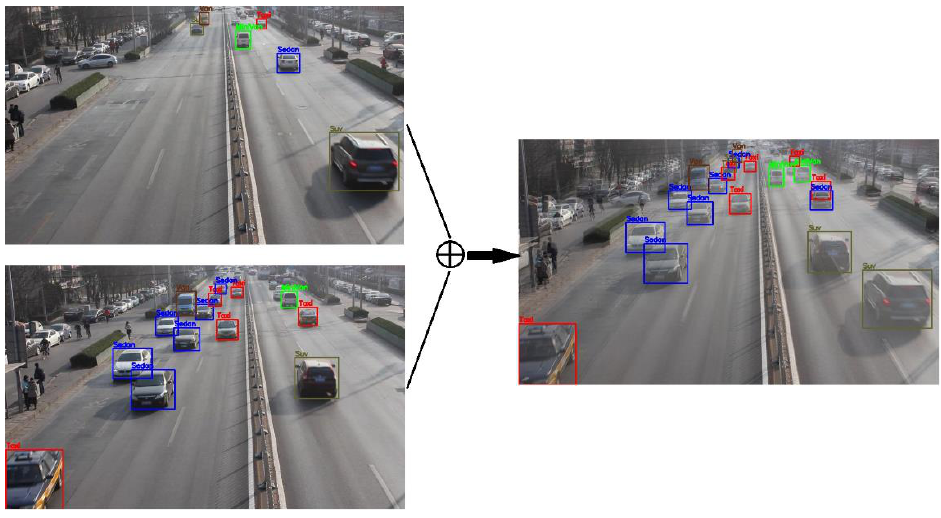
Figure 6. Schematic diagram of Mixup.